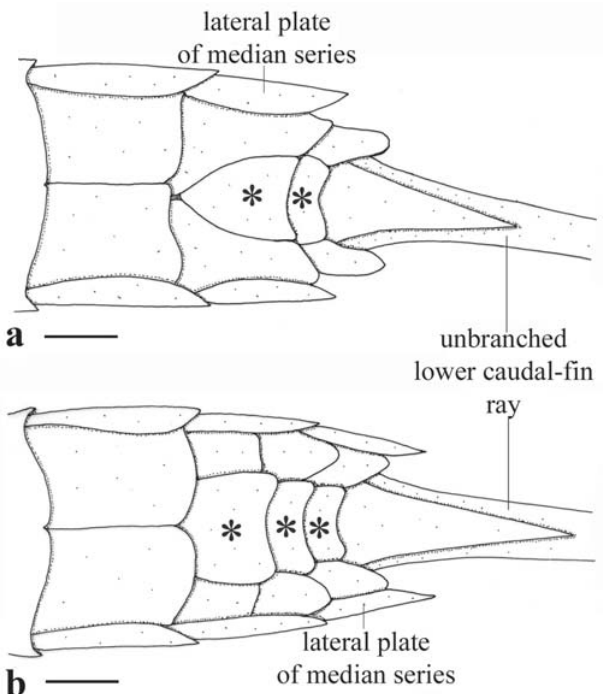
Fig. 7. Ventral view of distal tip of caudal peduncle of Lamontichthys parakana (INPA 3010, 112.7 mm SL, holotype) (a) and L . avacanoeiro (MZUSP 79750, 96.8 mm SL, paratype) (b). The asterisks indicate plates on the ventral mid-line of the caudal peduncle. Scale bar = 1